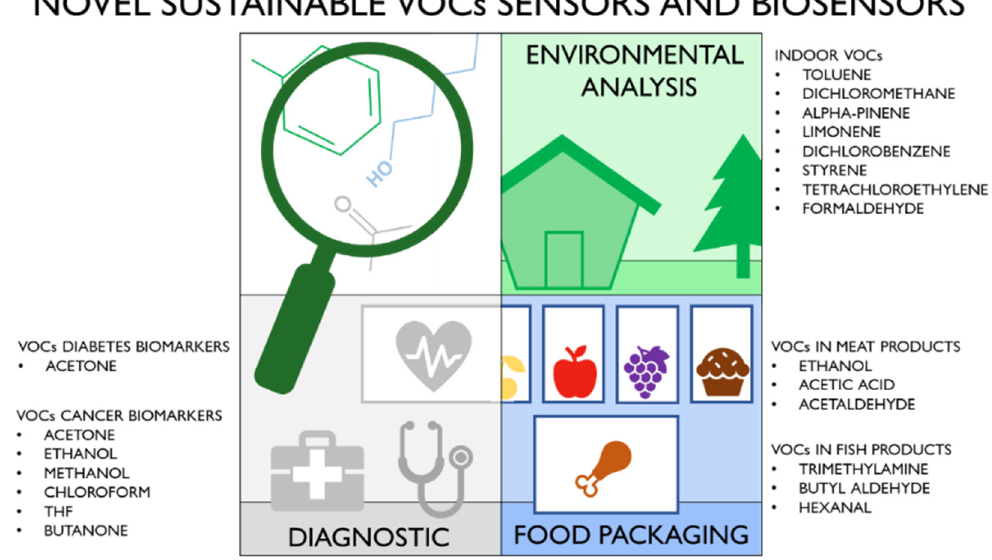
Figure 2. Field of applications of the novel sustainable sensors and biosensors and most relevant analyte VOCs reported in the present review.